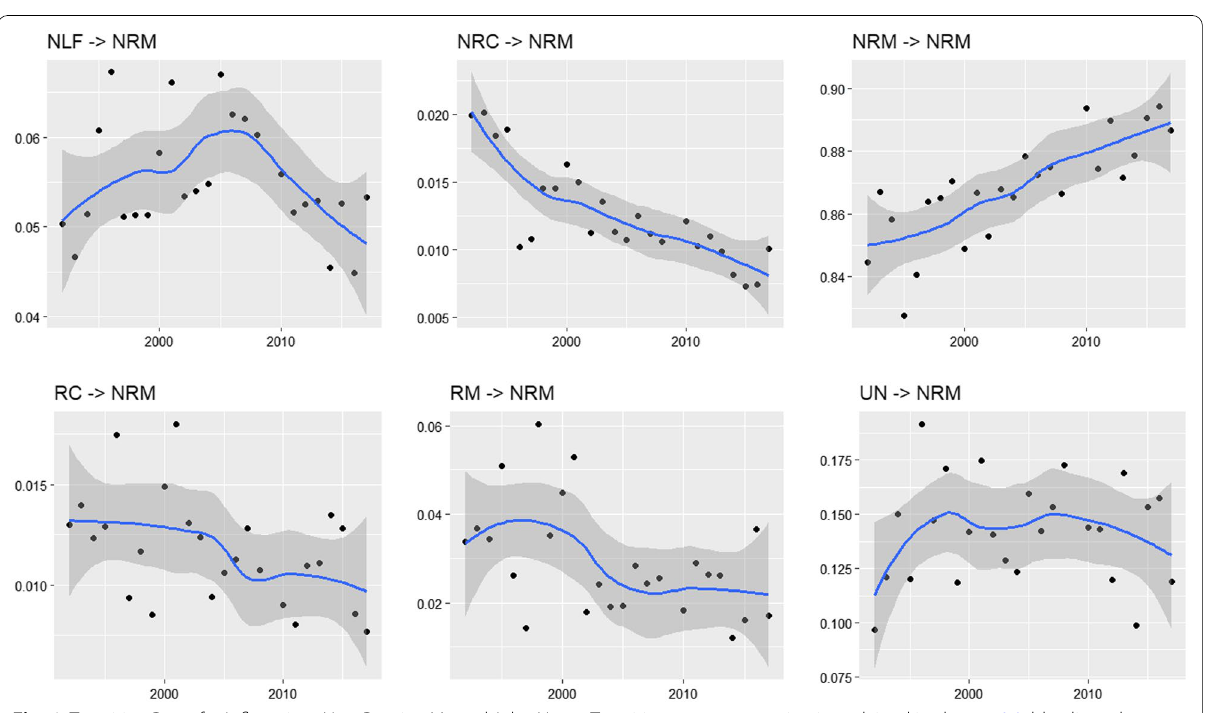
Fig. 6 Transition Rates for Inflows into Non-Routine Manual Jobs. Notes: Transition rate computation is explained in chapter 3.2, blue lines show local regression lines, and the gray area marks the 95% confidence interval. The figure also includes the stayer rate (NRM → NRM), the share of non-routine manual workers remaining in non-routine manual employment. Source: Swiss Labour Force Survey,